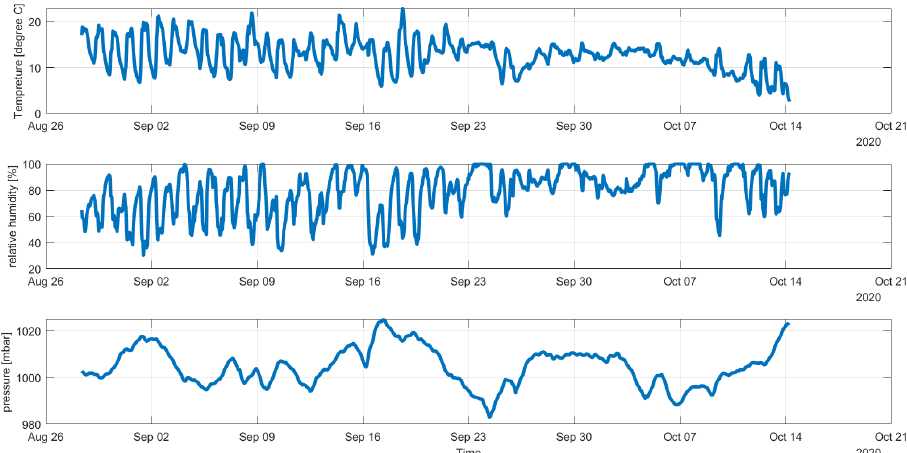
Figure 1. Meteorological parameters during the co-location campaign: air temperature ( top ), relative humidity ( center ) and atmospheric pressure ( bottom ).